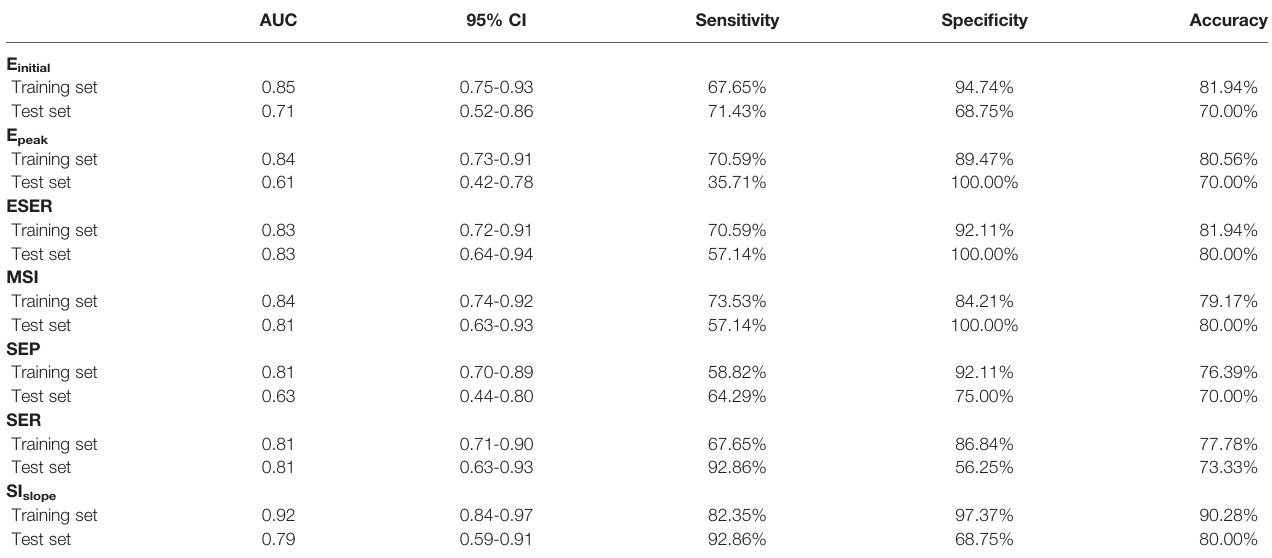
TABLE 6 | Performance of prediction models.